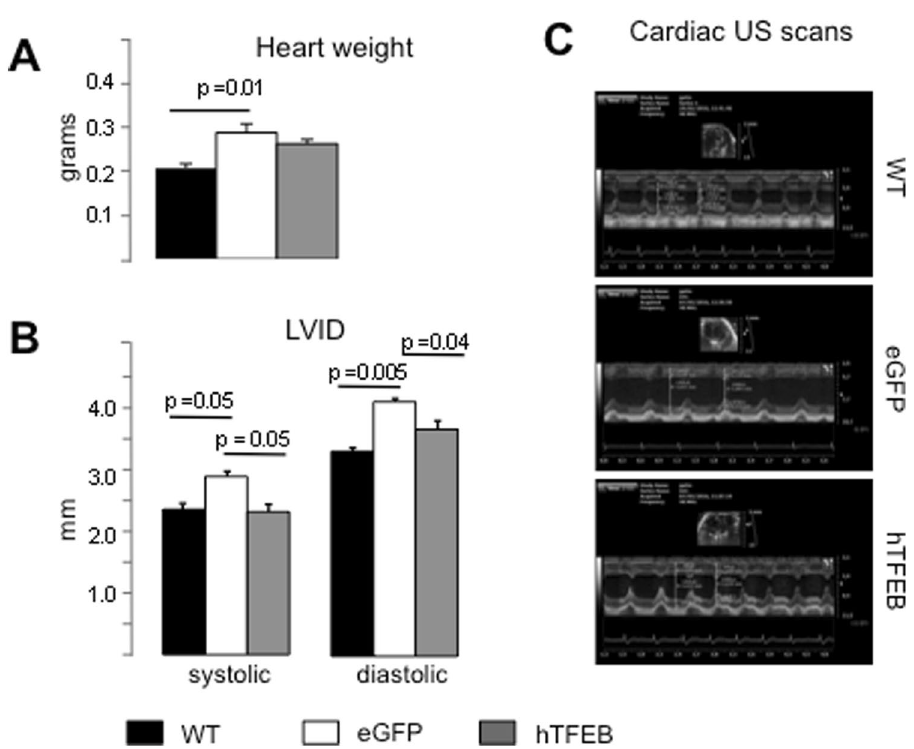
Figure 5. Cardiac parameters. ( A ) Heart weight expressed in grams of 8-mo old wildtype, knock out eGFP- treated and TFEB-treated mice. P value is obtained using one-tailed Student’s t-test. ( B ) Left Ventricular Internal Diameter. In TFEB-treated animals both systolic and diastolic diameters were significantly decreased compared to eGFP-treated knock out animals. P value is obtained using one-tailed Student’s t-test. ( C ) Representative echocardiography of wild type (WT), eGFP-treated, and TFEB treated knock out male mice at 8-mo